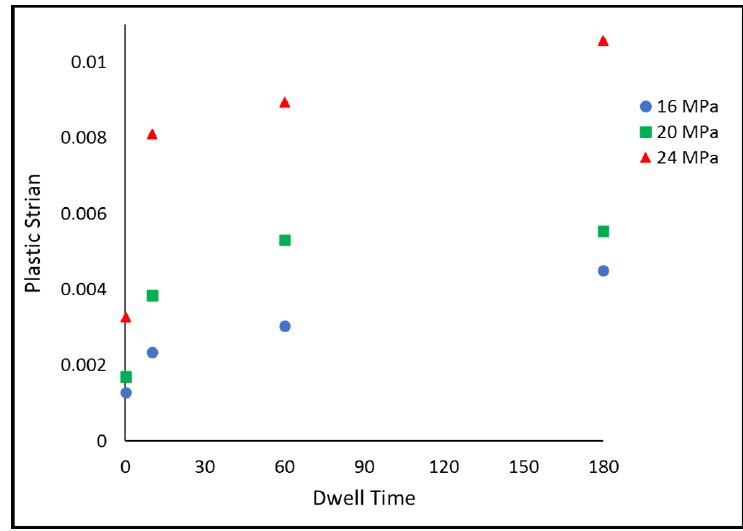
Figure 25. Plastic strain per cycle as a function of dwelling times at various stress levels.